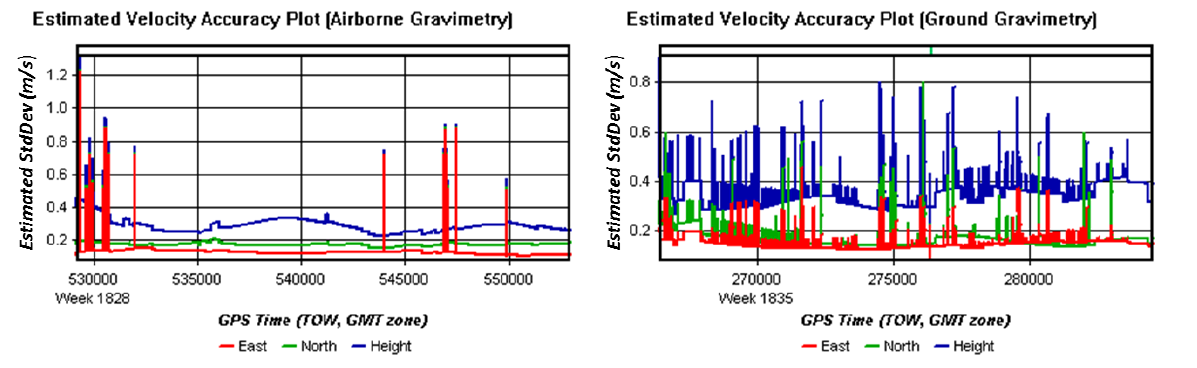
Figure 9. Estimated velocity accuracy plots of airborne and ground test.